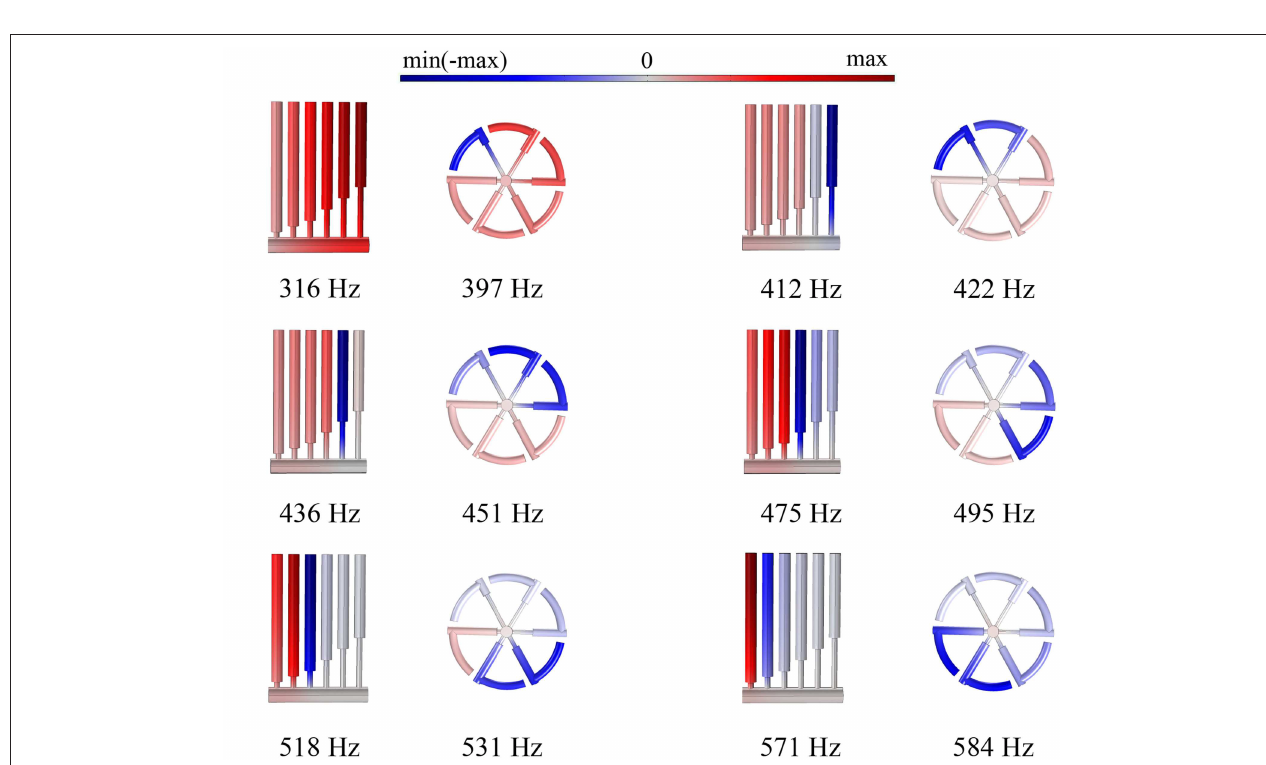
FIGURE 7 | The pressure distributions at the absorption peaks shown in Figure 4 , bottom and Figure 6 .